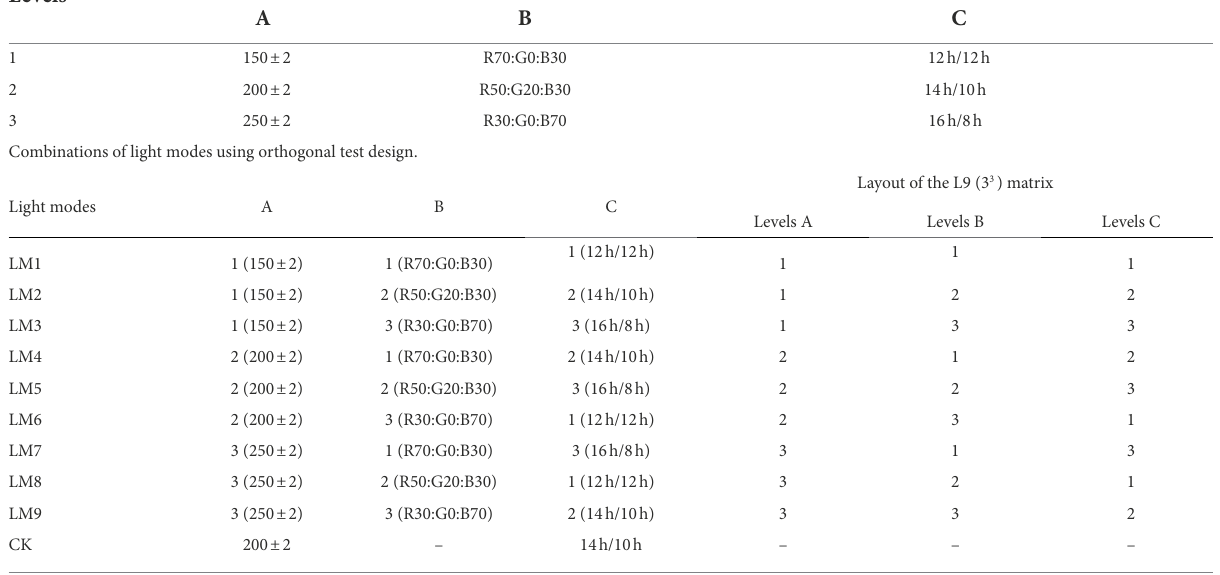
TABLE 1 Factors and levels of orthogonal experimental design.